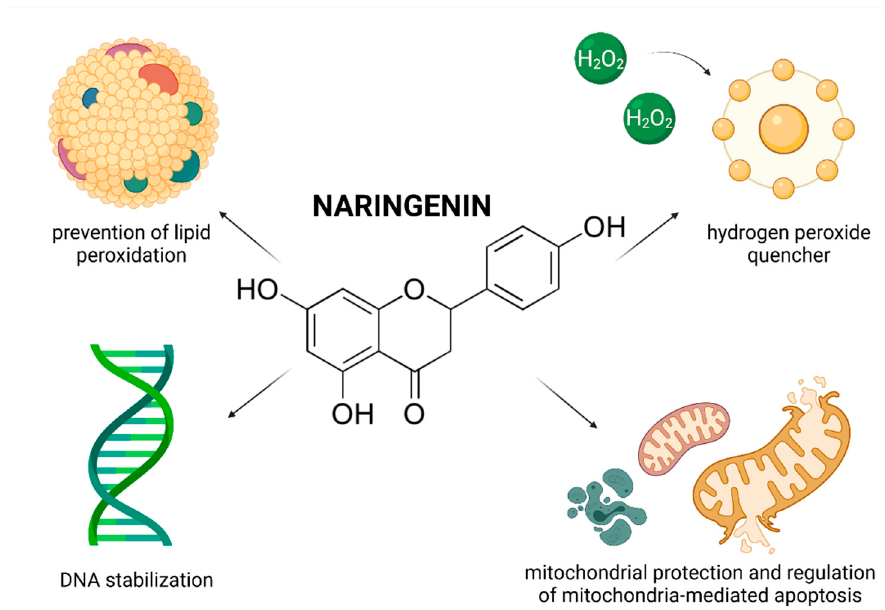
Figure 9. Most frequently reported beneficial effects of naringenin on spermatogenesis, sperm struc- structural integrity and functional tural integrity and functional activity.